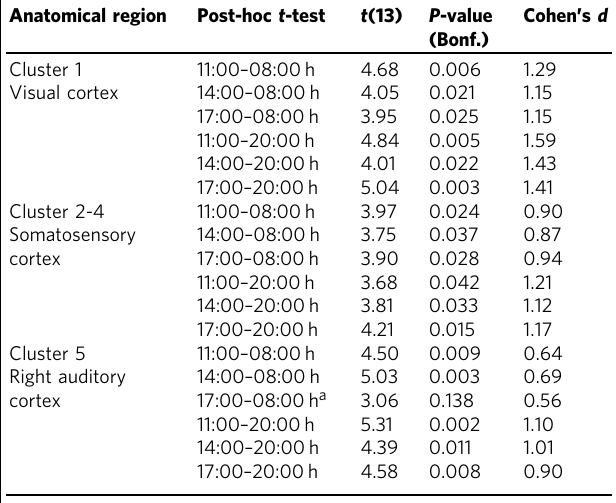
Table 2 Repeated measures ANOVA post-hoc t -tests on resting-state BOLD SD Anatomical region Post-hoc t -test t (13) P -value